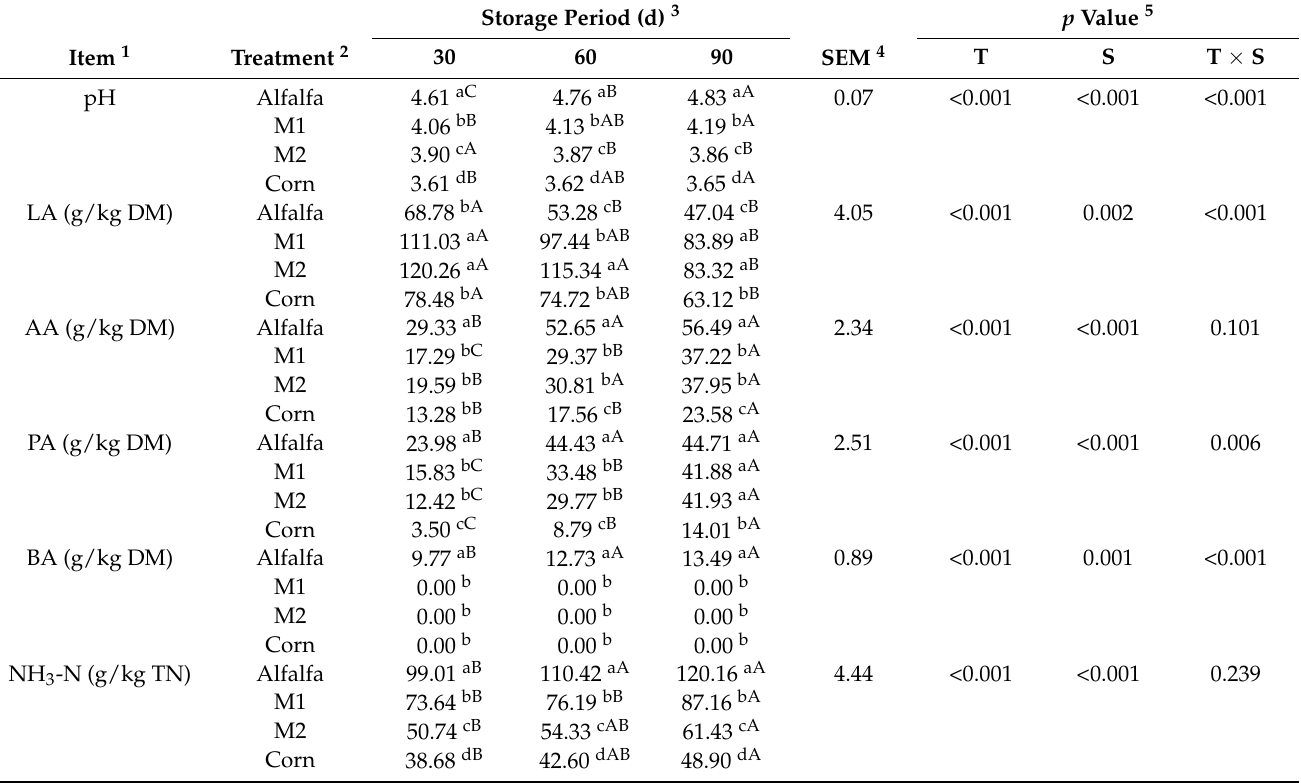
Table 1. Dynamics of fermentation profile of silage during storage ( n =